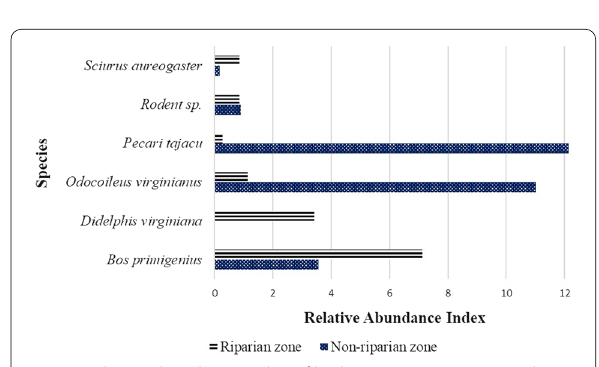
Fig. 5 Relative abundance index of herbivores, omnivorous and granivores mammals in riparian and non‑riparian zones